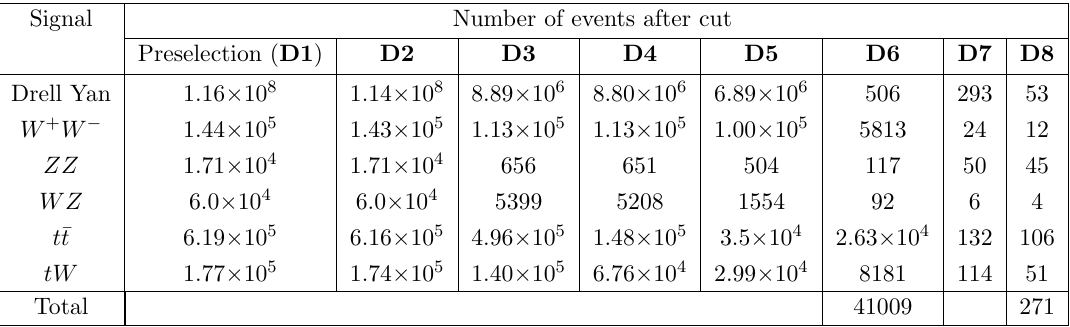
Table 10 . Opposite Sign di-lepton + =E (cid:12)nal state number of events at 100 fb (cid:0) 1 for Standard T Model backgrounds. Note that the events have been rounded-o(cid:11) to the nearest integer. Cross- sections scaled with K-factors at NLO [178] and wherever available, NNLO [191{196] have been used. case, BP2-a requires the least integrated luminosity and is in fact gives a 3 (cid:27) signi(cid:12)cance